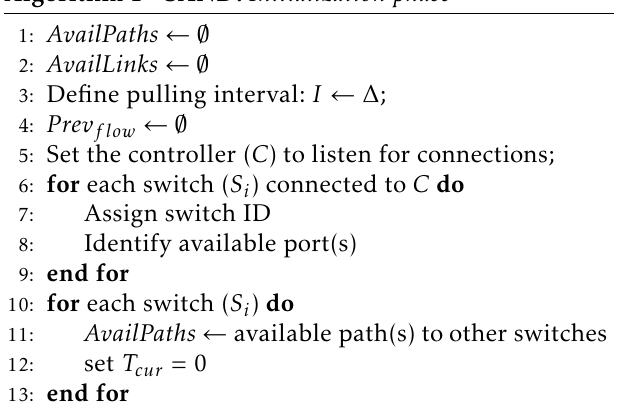
Algorithm 1 - SAND: Initialization